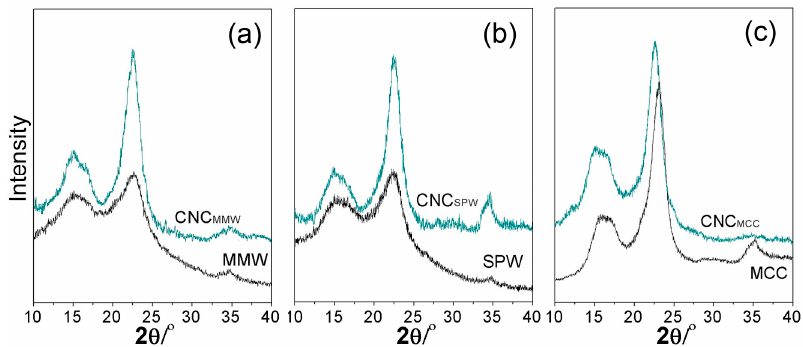
Figure 5. X-ray powder diffractograms of the hydrolyzed residuals (HRs), MCC, and the CNCs. ( a ) MMW and its resulted CNC MMW ; ( b ) SPW and its resulted CNC SPW ; ( c ) MCC and its resulted CNC MCC